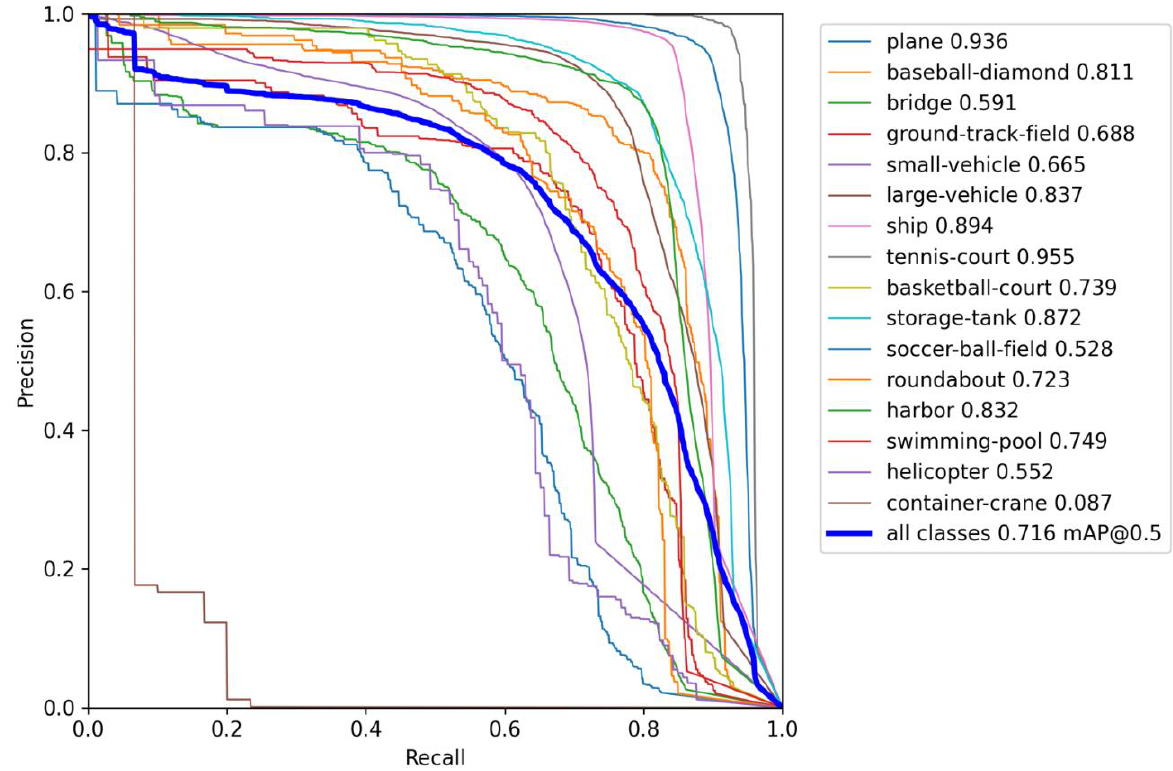
Figure 4. The P-R curve from the SPH-YOLOv5 results on the DOTA test set.